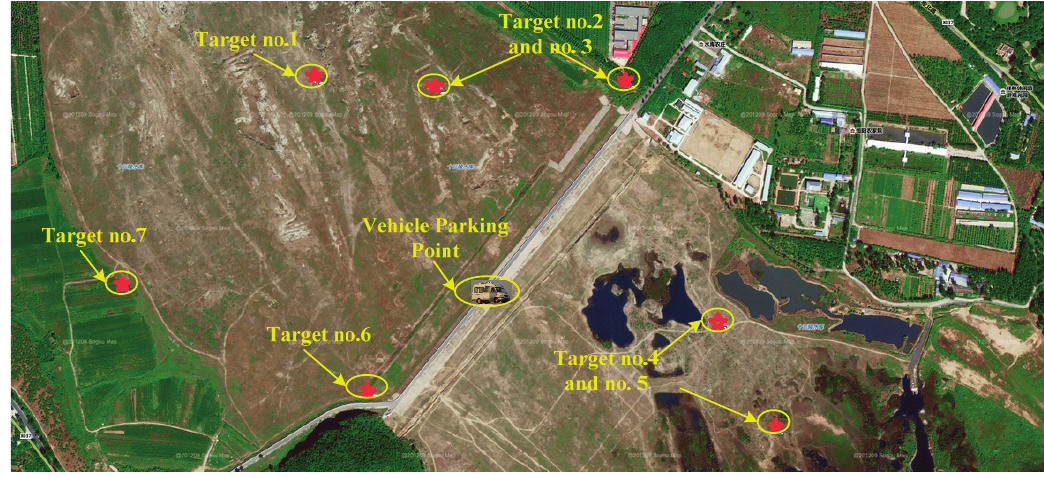
Figure 11. Distribution of the cooperative targets and vehicle.